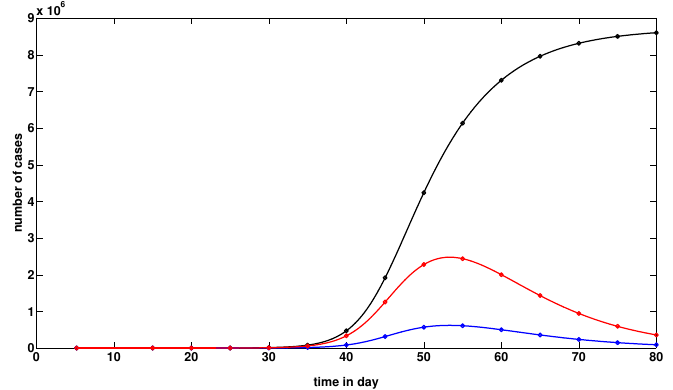
Figure 5. In this figure, we plot the graphs of t → CR ( t ) (black solid line), t → U ( t ) (blue solid line) and t → R ( t ) (red solid line). We use f = 0.8, η = 1/7, ν = 1/7, and S 0 = 11.081 × 10 6 . The remaining parameters are derived by using (6)–(8). We obtain τ = 4.44 × 10 − 08 , I 0 = 3.62 and U 0 = 0.2. The cumulated number of reported cases goes up to 8.5 million people and the turning point is day 54. Thus, the turning point is 23 February (i.e.,